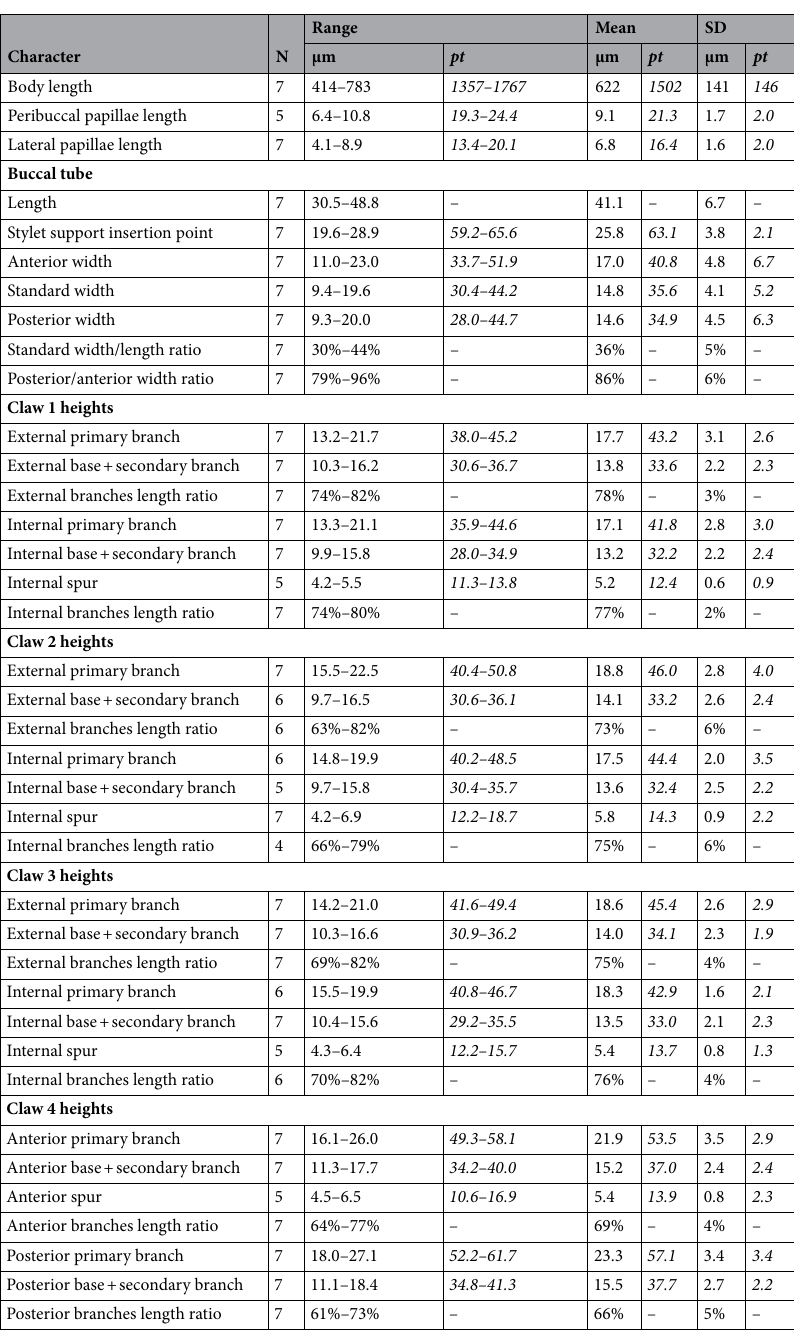
Table 3. Measurements (in μm) and the pt values of selected morphological structures of 5 females and 2 juveniles of Milnesium decorum sp. nov. from Portugal, PT.010, mounted in Hoyer’s medium. All available specimens were